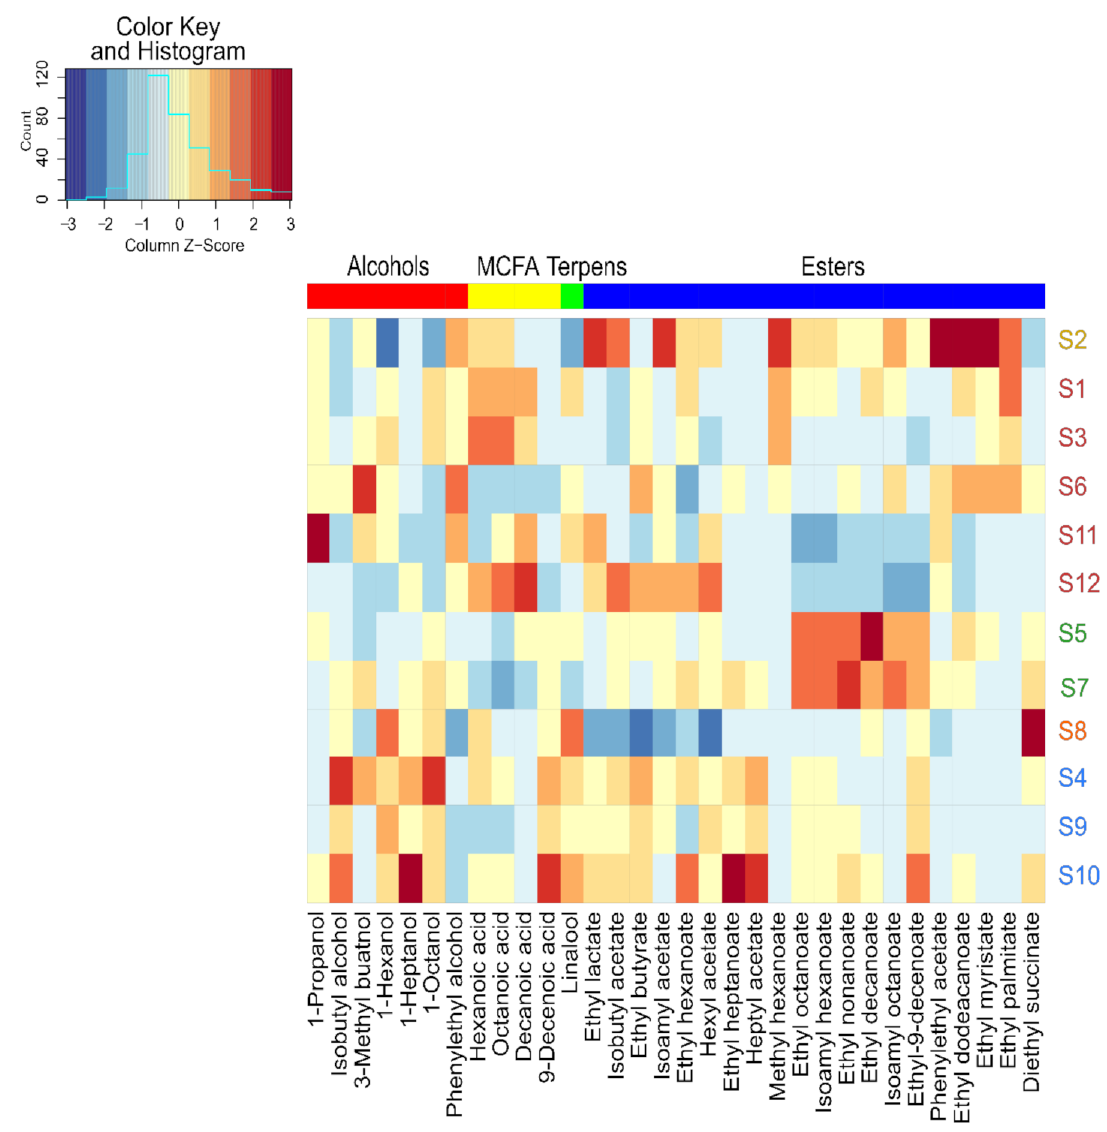
Figure 4. Heat map of volatile compounds produced by the different strains of Saccharomyces cerevisiae . Columns correspond to volatile compounds that presented significant differences between twelve strains. Colored samples represent different class obtained from